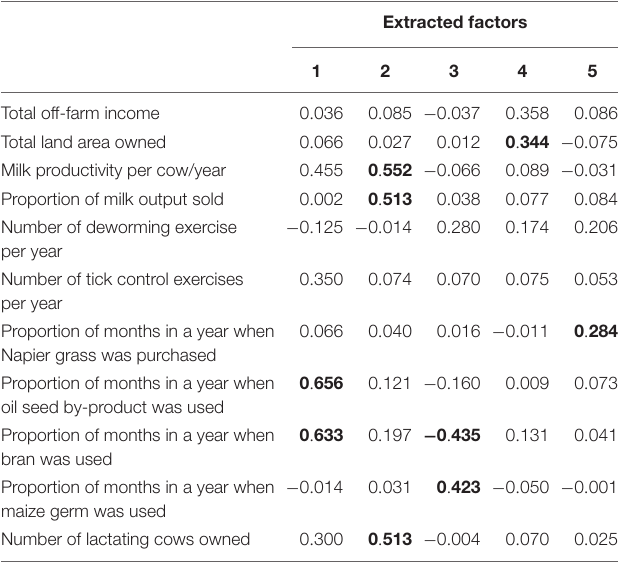
Extraction method: principal axis factoring. Rotation method: varimax with Kaiser normalization. Bolded values are the highest for each extracted factor and represent the determinants with the highest